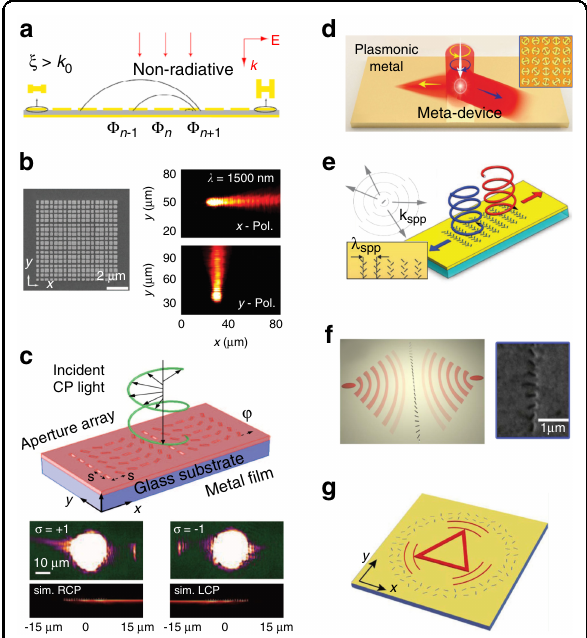
Fig. 8 Excitations of surface waves using meta-structures. a Physical principle of PW-SW conversion by phase-gradient metasurface 70 . b Polarization-dependent directional SPP excitation at telecom wavelengths 115 . c Helicity-dependent directional SPP excitations via Pancharatnam – Berry (PB) phase metasurfaces 113 . d Schematic of terahertz Metasurfaces for spin-delink spoof SPPs excitation combining the resonant and PB phase gradient. Inset: Partial picture of the fabricated meta-structure 119 . e Schematic of aperture-based SPP meta-coupler for polarization-modulated directional SPP coupling. Inset: image of multiple parallel column aperture pairs spaced λ SPP apart 112 . f A plasmonic meta-slit that can achieve fl exible SPP focal length switching by the helicity of input circular polarized (CP) light 122 . g Ring-shape array of nano-slits for SPP hologram 337 . Panels adapted from: Springer Nature ( a 70 , b 115 , c 113 ); Wiley ( d 119 , g 337 ); AAAS ( e ) 112 ; OSA ( f ) 122